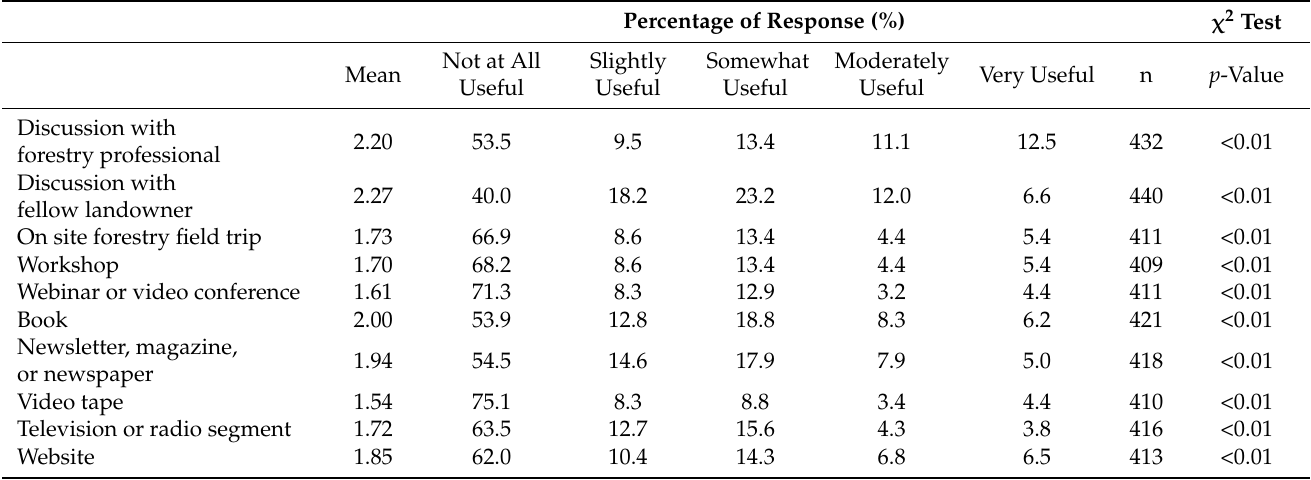
Table 5. Landowners’ main sources of information about forest management